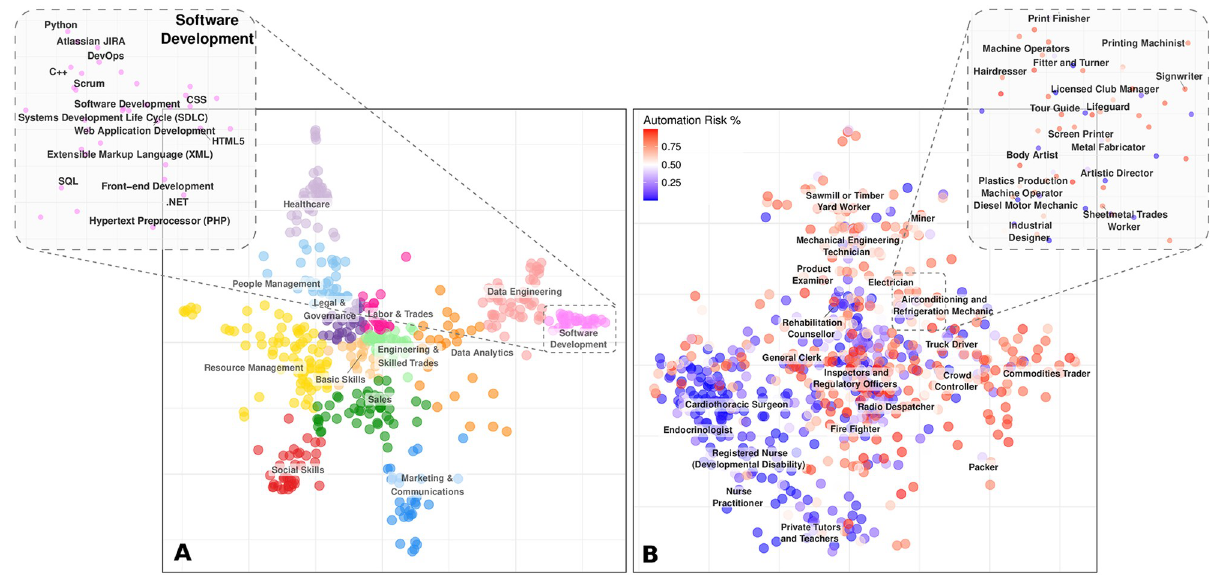
Fig 1. Measuring the distance between skills and occupations. (A) Shows a two-dimensional embedding of the 2018 skill distances, where the top 500 skills by posting frequency are visualized. Each marker represents an individual skill colored according to 13 clusters using K-Medoids clustering. As observed in the ‘Software Development’ inset, highly similar skills cluster together. Additionally, the specialized skill clusters, such as ‘Software Development’ and ‘Healthcare’ tend to lay toward the edges; whereas the more general and transferable skills lay toward the middle of the embedding and act as a ‘bridge’ to specialist skills. These individual skill distances form the basis of measuring the distance between sets of skills. (B) We leverage S KILLS S PACE to measure the distance between official Australian occupations at the 6-digit level (characterized by their skill sets) in 2018. The markers represent individual occupations, colored by technological labor automation risk, as calculated by Frey & Osborne. Occupations that require higher levels of routine, manual and/or low cognitive labor tasks tend to be at higher risk (colored darker red); whereas occupations characterised by non- routine, interpersonal, and/or high cognitive labor tasks are at lower risk (colored darker blue) over the next two decades.